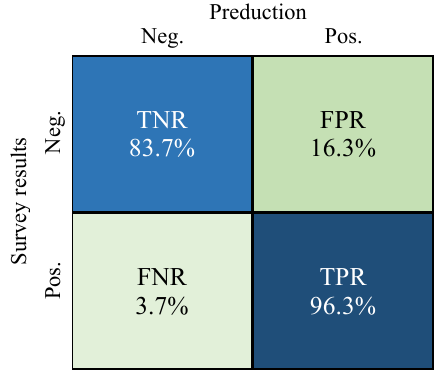
Figure 10. Confusion matrix for KNN